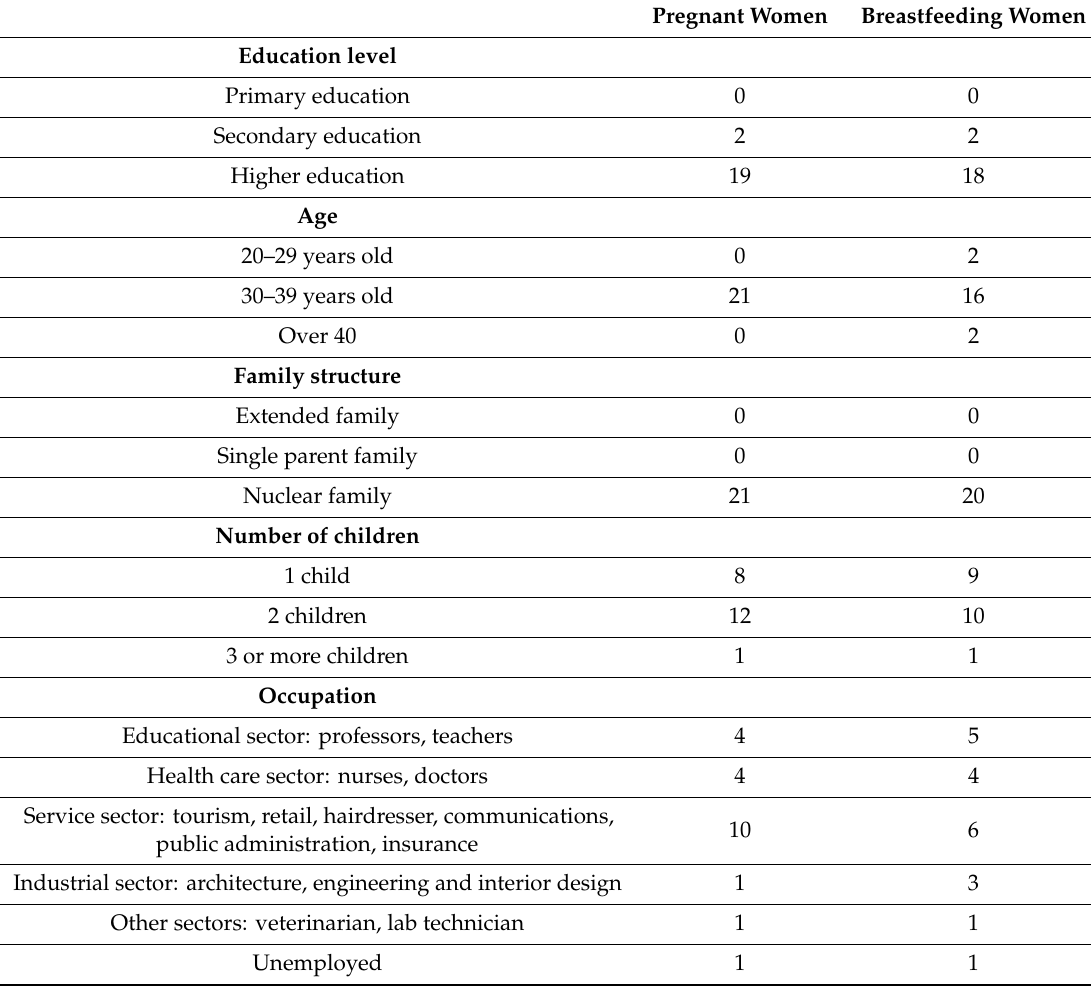
Table 2. Socio-demographic and socioeconomic characteristics of the women who completed the activity with or without